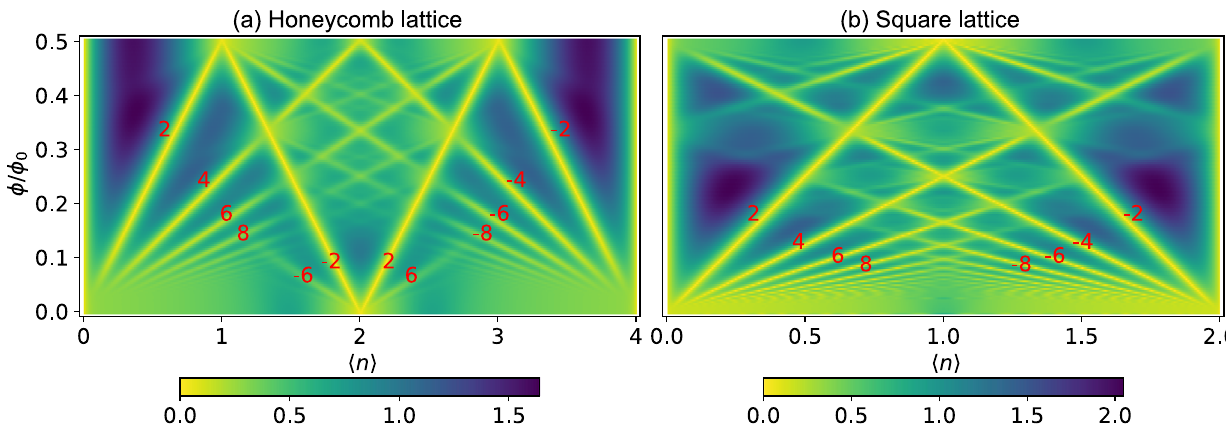
Fig. 1 Noninteracting compressibility for square and honeycomb lattice. Noninteracting compressibility as a function of magnetic fl ux ϕ and electron density 〈 n 〉 for ( a ) honeycomb lattice ( N site = 36 × 36 × 2) and ( b ) square lattice ( N site = 40 × 40) at β / t = 20. The leading quantum Hall states are labeled with the corresponding Chern